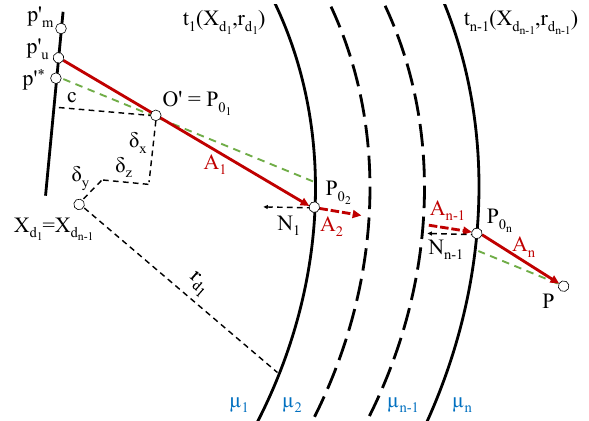
Figure 1. Forward ray tracing through n media for a single point. From the measured point p ′ m , distortion correction is applied to gain p ′ u . The outgoing ray ⃗A i (red) is then refracted at n − 1 interfaces t i , considering refractive indices µ i and µ i +1 and the normal vectors at their intersection points ⃗N i . An unrefracted ray (green) with the projected point p ′∗ is depicted for